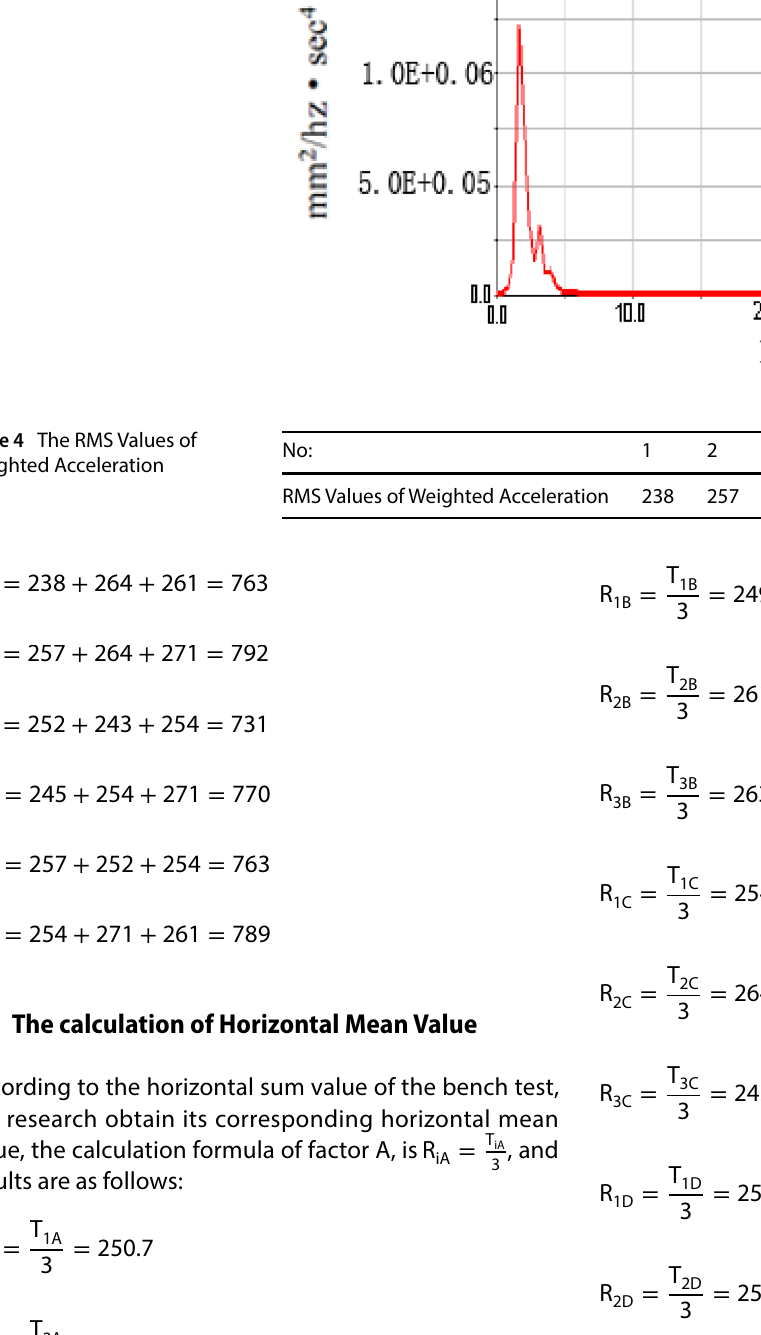
Fig. 14 Test 9. Acceleration Response Curve